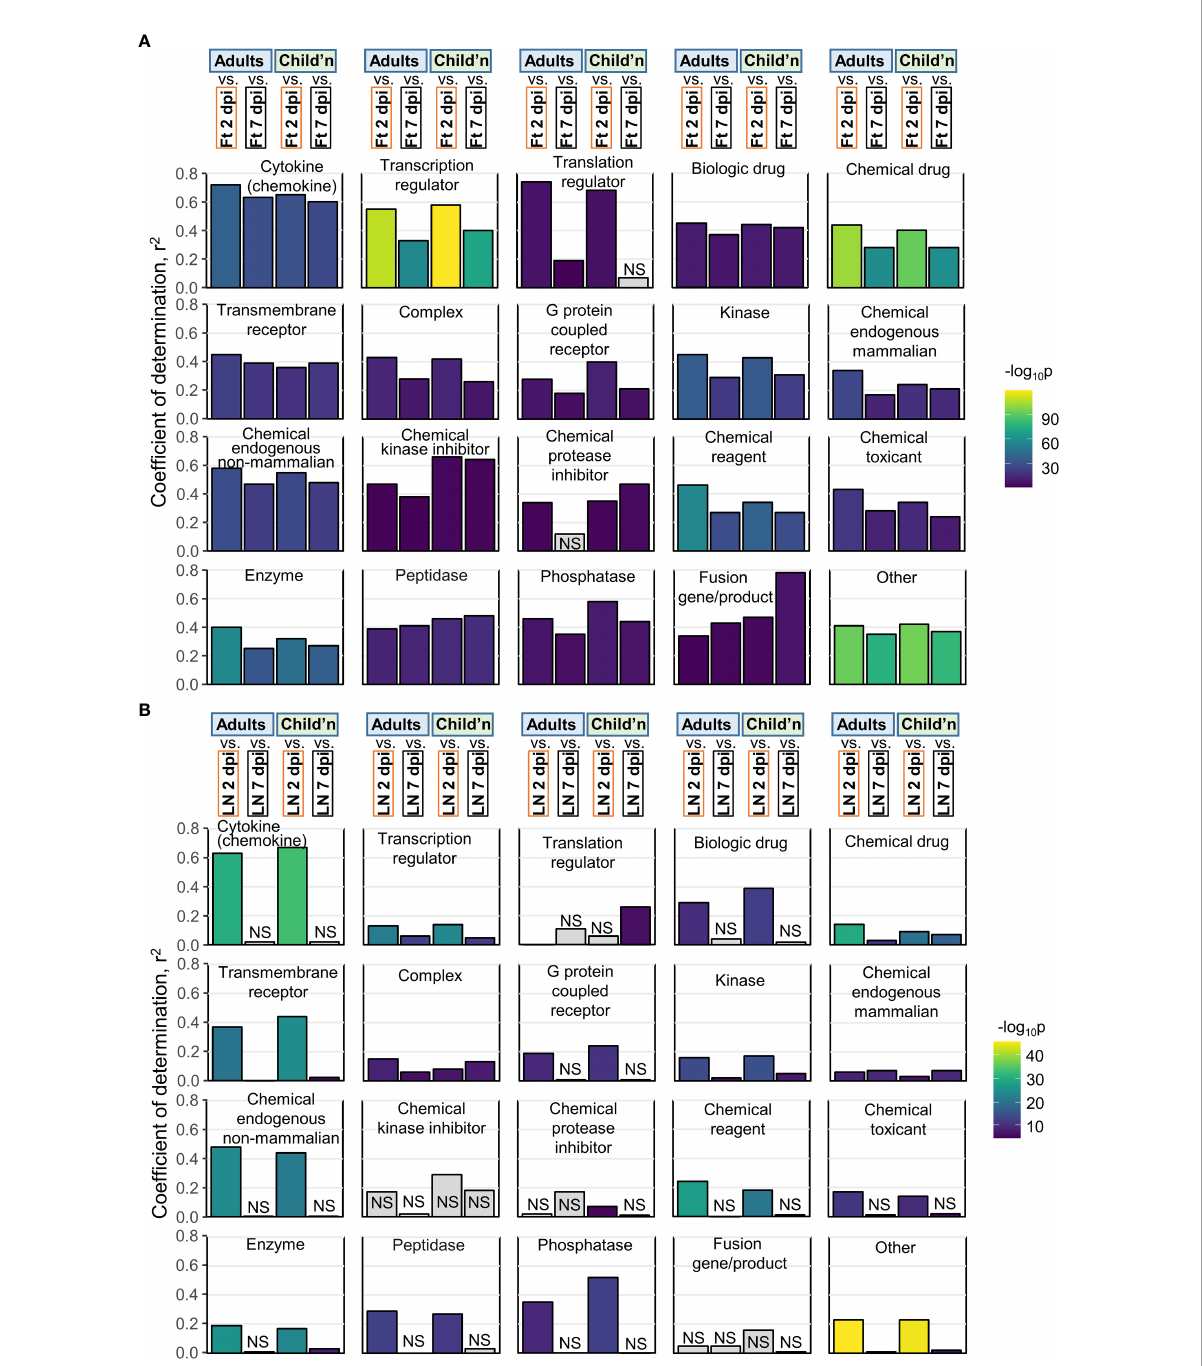
FIGURE 5 Pearson correlations for IPA USRs. (A) The DEGs from Adults, Children, mice Ft 2 dpi, and mice Ft 7 dpi were analyzed by IPA to provide z- scores for signi fi cant USRs (p<0.05). The USRs were then grouped by Molecule type and Pearson correlations undertaken. For example, top left, Cytokine, compares Adults Cytokine USR z-scores with mice feet 2 dpi and 7 dpi Cytokine USR z-scores (correlation plot shown in Figure S6A). (B) As for a, but correlations with mice LN 2 and 7